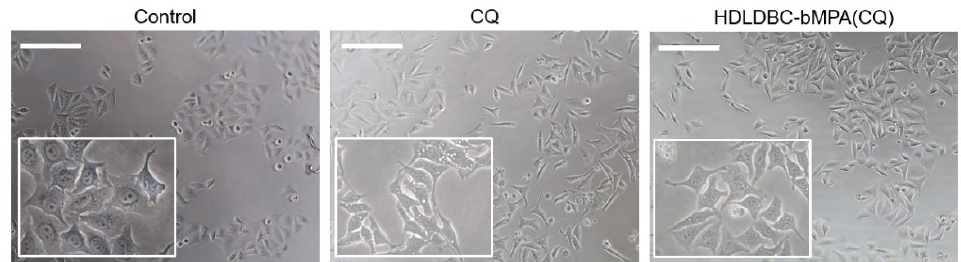
Figure 5. Effect of CQ on HeLa cell morphology. Cells were treated with 40 µ M of CQ or encapsulated HDLDBC-bMPA(CQ) for 24 h. Cell damage was evaluated by analysis of cell micrographs obtained on a phase contrast microscope. Scale = 200 µ m